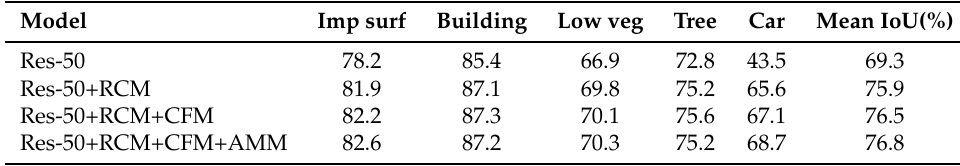
Table 5. Detailed performance comparison of network modules (class IoU and mean IoU). RCM: Residual Convolutional Module. CFM: Context Fuse Module. AMM: Attention Mix